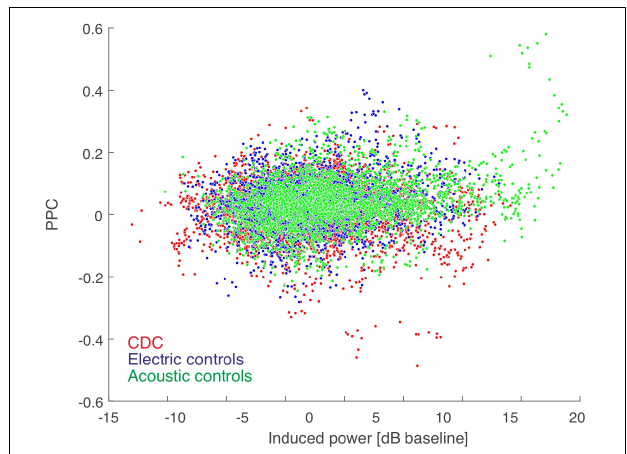
FIGURE 3 | PPC-based connectivity is not a direct consequence of induced power (summed for the pair). Color code shown in the inset. The Spearman correlation coefficient was very low (rho = 0.071 for acoustic controls, rho = 0.017 for electric controls, and rho = 0.002 for CDCs, all p < 0.05) and thus induced power contributed minimally to the PPC result. There was no difference between the three groups of animals in power-PPC